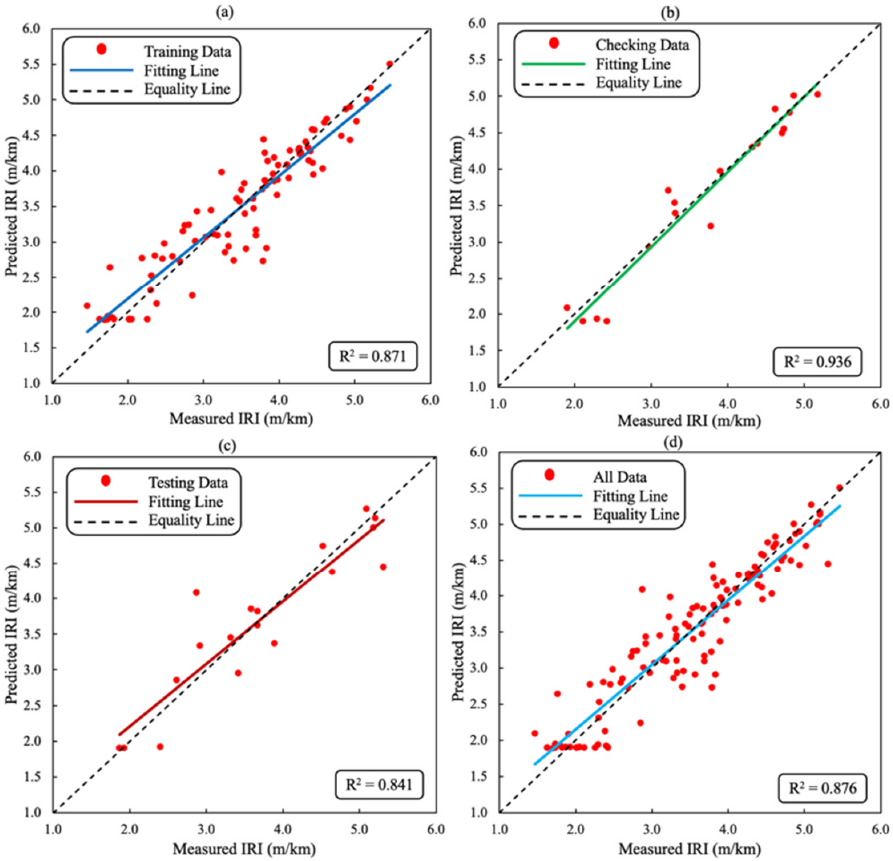
Figure 15. AC regression analysis results between measured and predicted IRI values for the ( a ) training, ( b ) checking, ( c ) testing, and ( d ) all data.